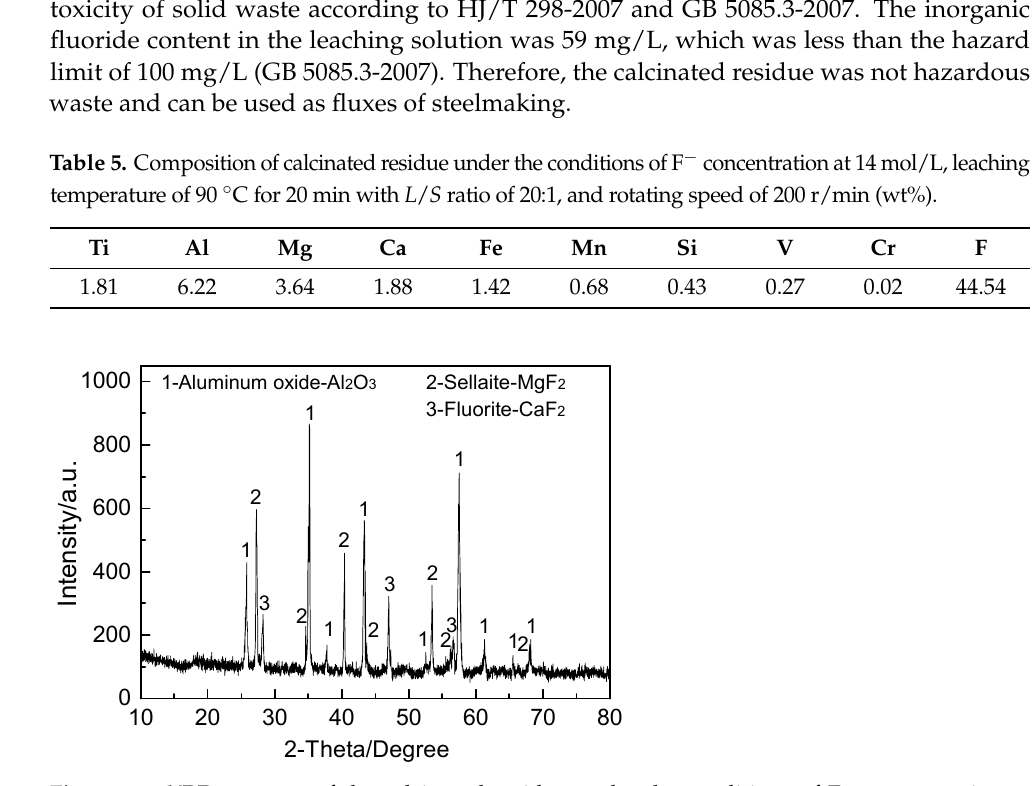
Figure 13. XRD patterns of the calcinated residue under the conditions of F − concentration at 14 mol/L, leaching temperature of 90 °C for 20 min with L / S ratio of 20:1, and rotating speed of 200 r/min.